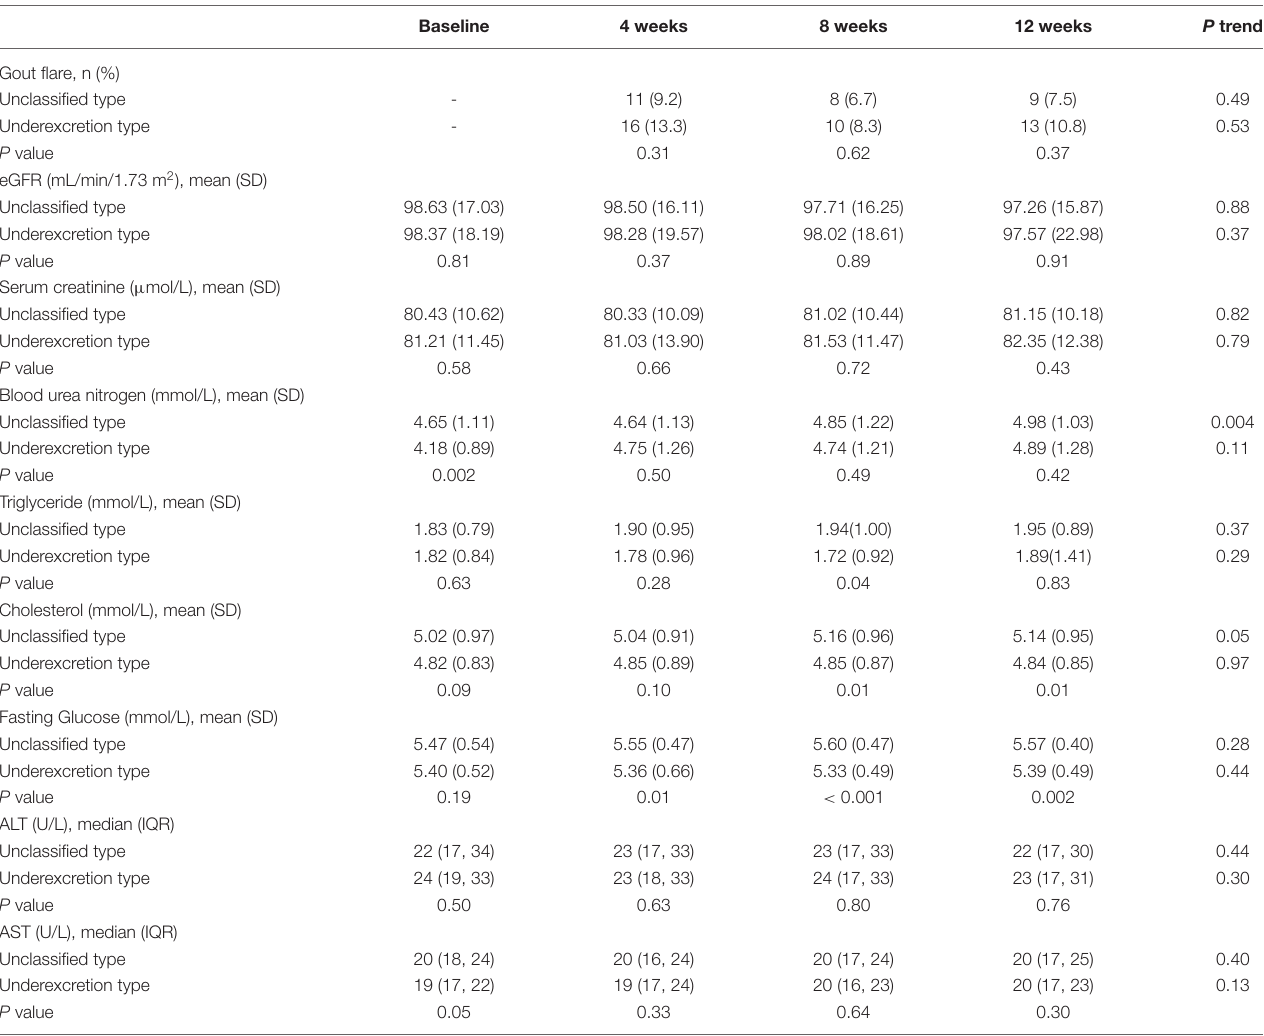
TABLE 2 | Changes in the clinical characteristics during the